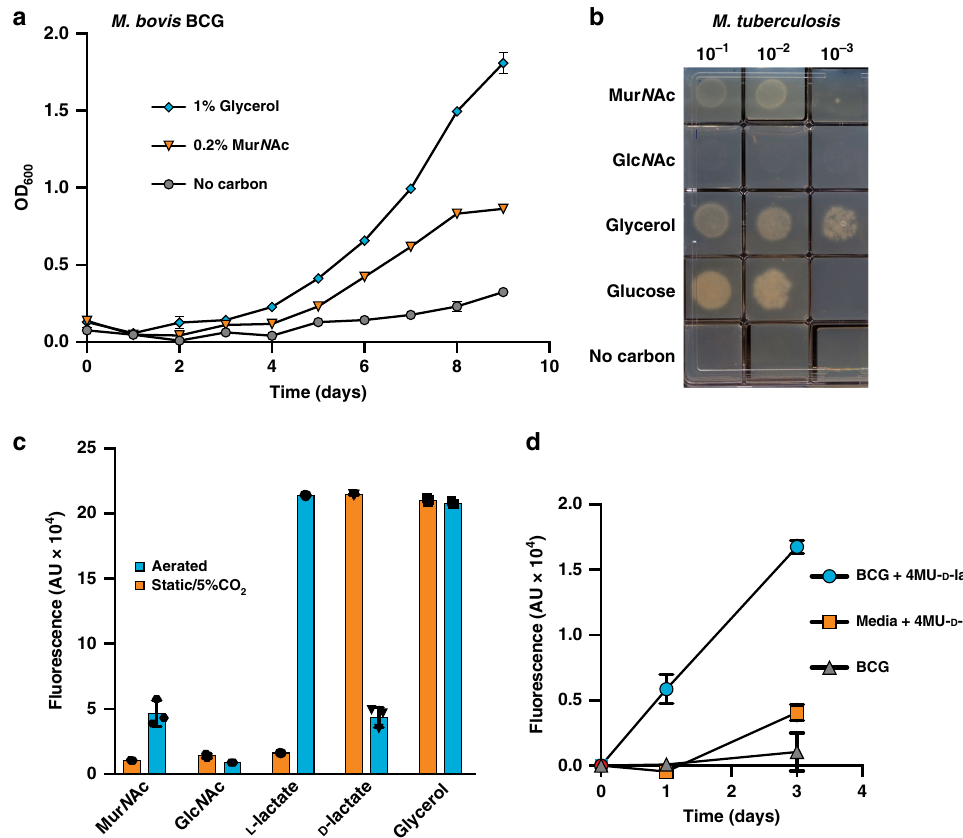
Fig. 3 M. tuberculosis and M. bovis BCG are able to recycle Mur N Ac. a M. bovis BCG WT was inoculated at a starting OD 600 of 0.1 in Sauton ’ s minimal media containing glycerol (blue diamonds), Mur N Ac (orange triangles), or no carbon (grey circles) and growth was monitored daily by taking OD 600 readings at the indicated time points ( n = 3; error bars are ± SD). b M. tuberculosis H37Rv was washed and then serially diluted into fresh carbon-free minimal media. 10 μ L of each dilution was spotted onto Sauton ’ s agar containing the indicated carbon sources at 5 mM. c Growth of M. bovis BCG on 5 mM Mur N Ac, Glc N Ac, L -lactate, D -lactate, and glycerol was evaluated in aerated (blue) or static 5% CO 2 (orange) cultures using a resazurin assay ( n = 3; error bars are ± SD). d Mid-exponential M. bovis BCG was grown in minimal media with 5 mM glycerol including 1 mM 4MU- D -lactate (blue circles) with constant agitation. At the indicated times, the 4MU fl uorescence of the samples was determined in a BMG Polarstar plate reader ( n = 3; error bars are ± SD) and compared with controls without cells (orange squares) or without 4MU- D -lactate (grey